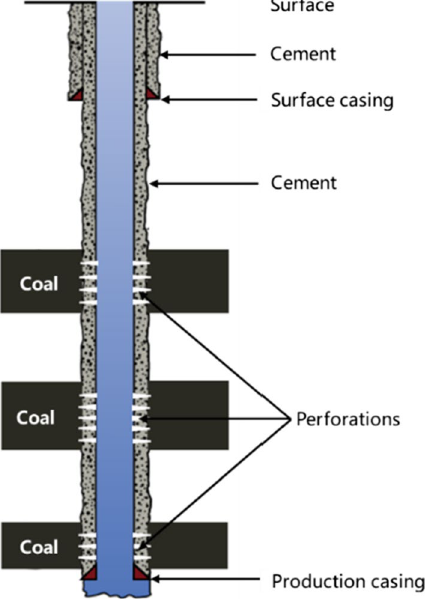
Fig. 28 Schematic of case-hole completion for multiple coalbeds, modified from Flores (2013)